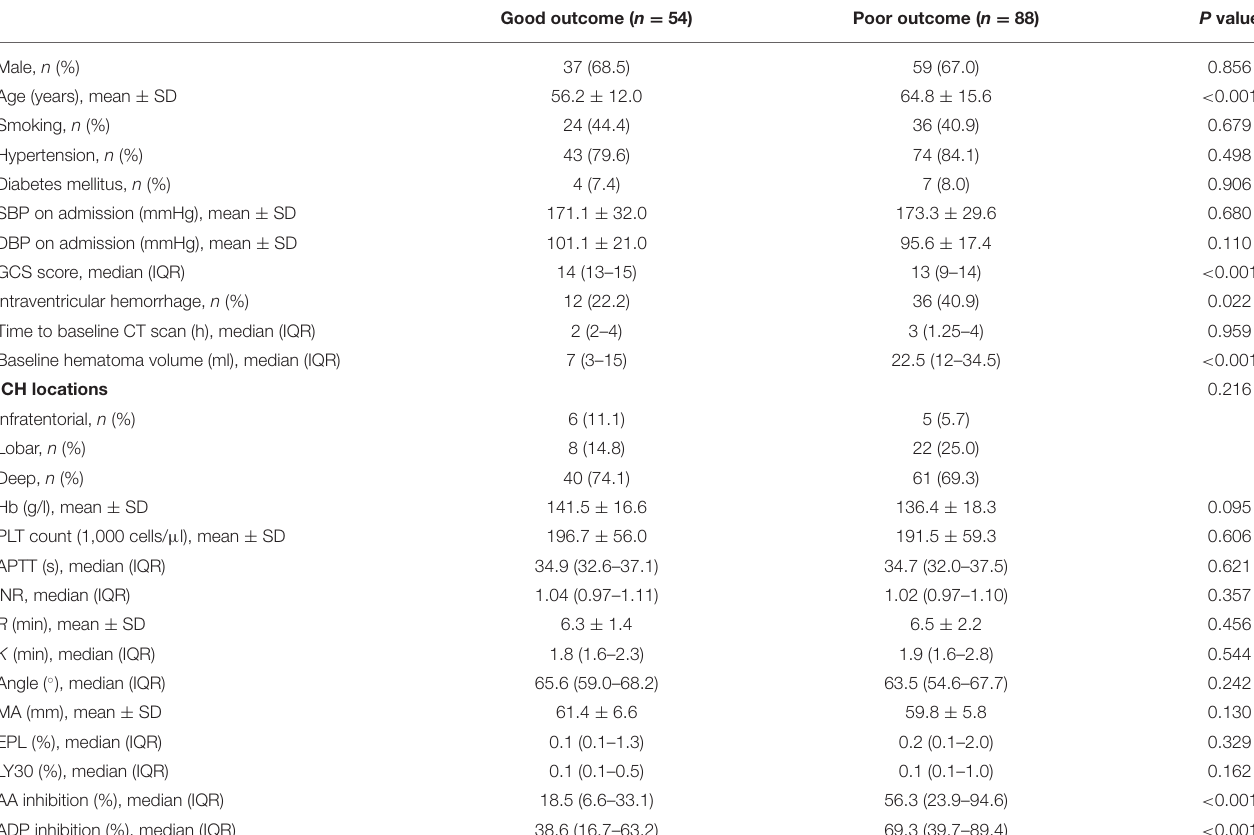
TABLE 3 | Univariate comparison between patients with good outcome (mRS 0–2) and poor outcome (mRS 3–6). Good outcome ( n =